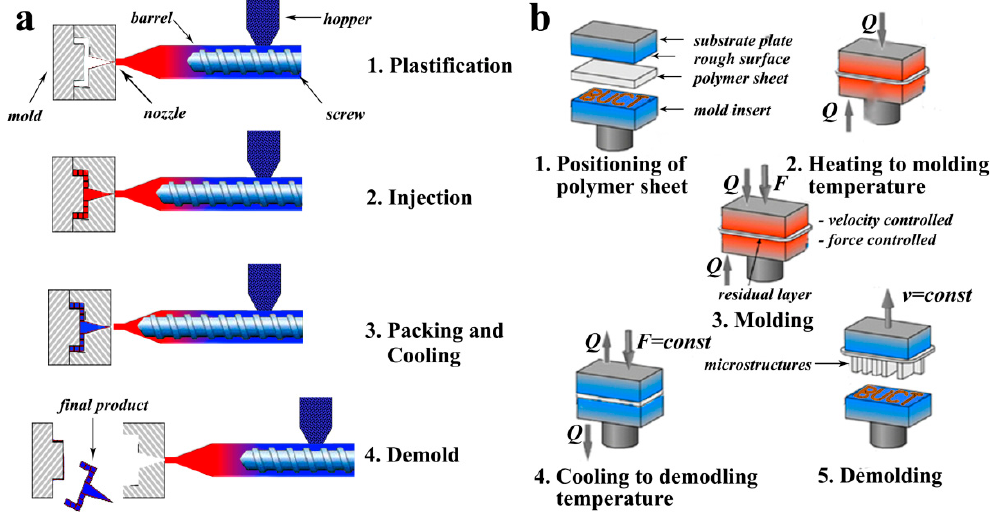
Figure 7. ( a ) Schematic diagram of an injection molding machine and the major steps of the injection molding procedure. ( b ) Schematic diagram of a hot embossing machine and the major steps of the hot embossing procedure.